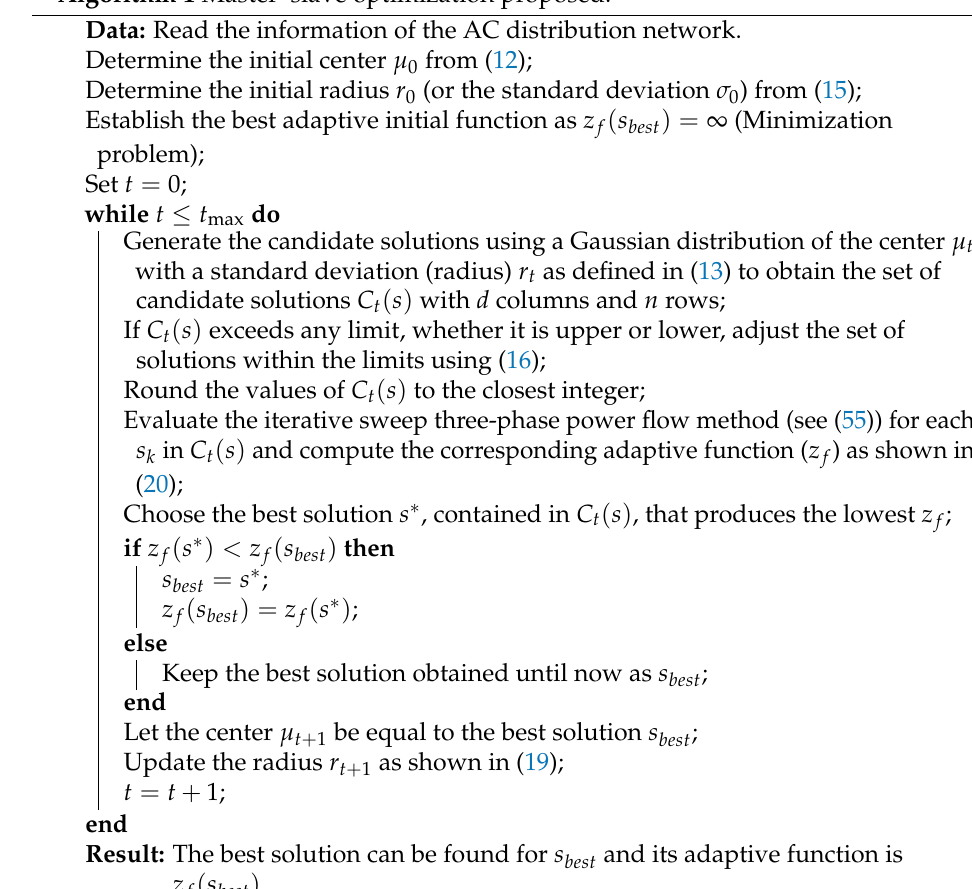
Algorithm 1 Master–slave optimization proposed.